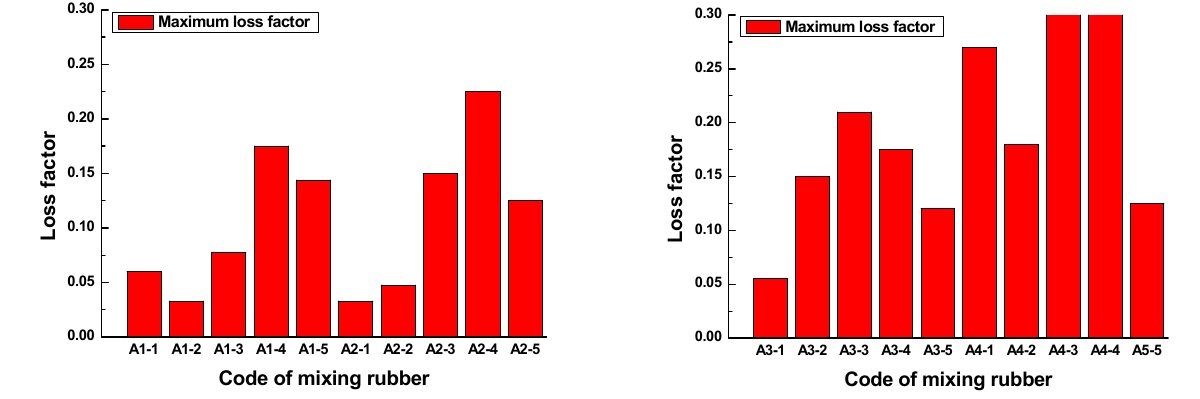
Figure 16. The maximum loss factor of the rubber samples.